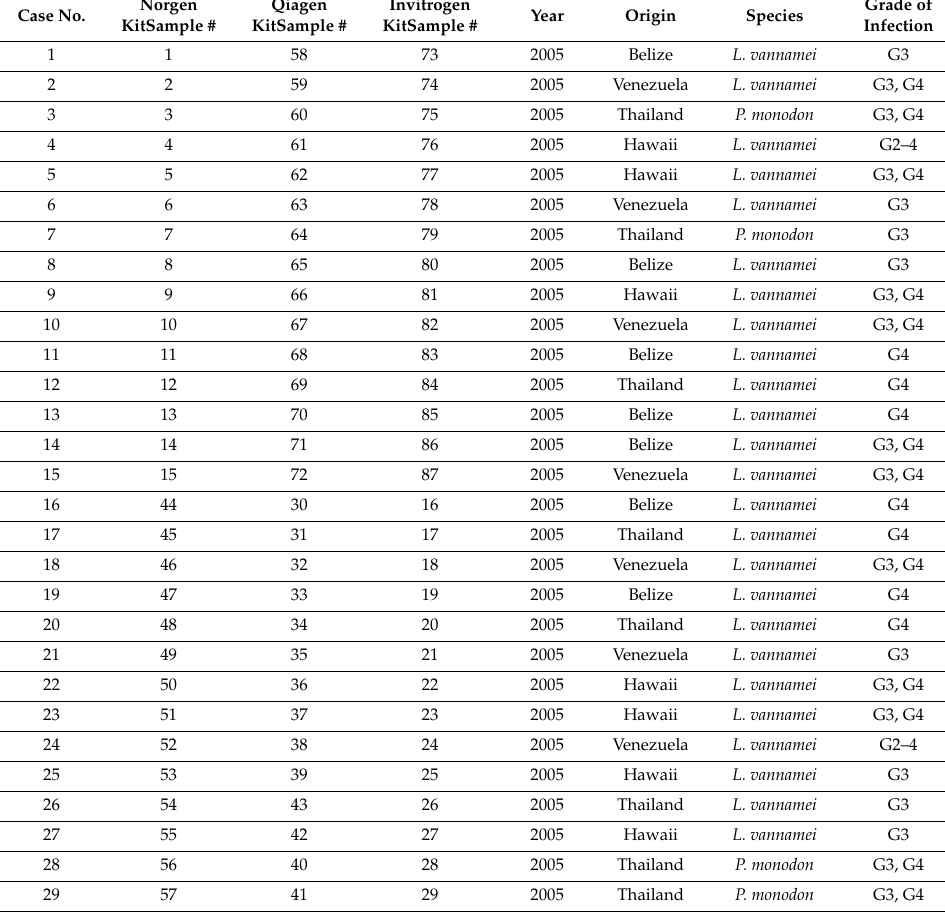
Figure 1. Taura syndrome virus (TSV) infection in Litopenaeus vannamei . ( A ) Focal acute-phase infection (large arrow) in the cuticular epithelium characterized by spherical intracytoplasmic inclusions bodies, pyknosis and karyorrhexis. Scale bar, 50 µ M. ( B ) High magnification of the same section; the basophilic intracytoplasmic inclusions bodies (black arrow) and pyknotic nuclei (red arrow) are shown. Scale bar, 20 µ M. Table 1. Archived Davidson’s-fixed para ffi n-embedded (DFPE) tissue samples selected for analyses. The cases ( n = 29) are displayed with their corresponding sample numbers from each of the three extraction kits (Invitrogen PureLink FFPE RNA Isolation Kit, Norgen Biotek FFPE RNA Purification Kit and Qiagen RNeasy FFPE Kit), the place of origin, the year each case was received, shrimp species and grade of infection (from G1 to G4, where G4 represents the highest level of TSV infection. Case